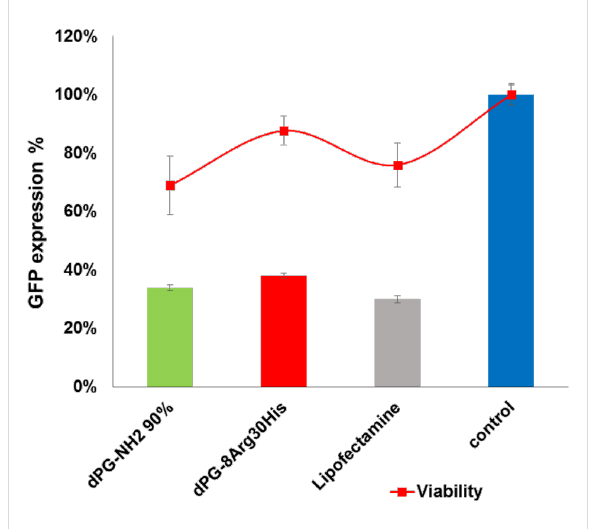
Figure 4: Cell viability versus transfection efficiency of dPG-8Arg30His and dPG-NH 2 90% at N/P ratio